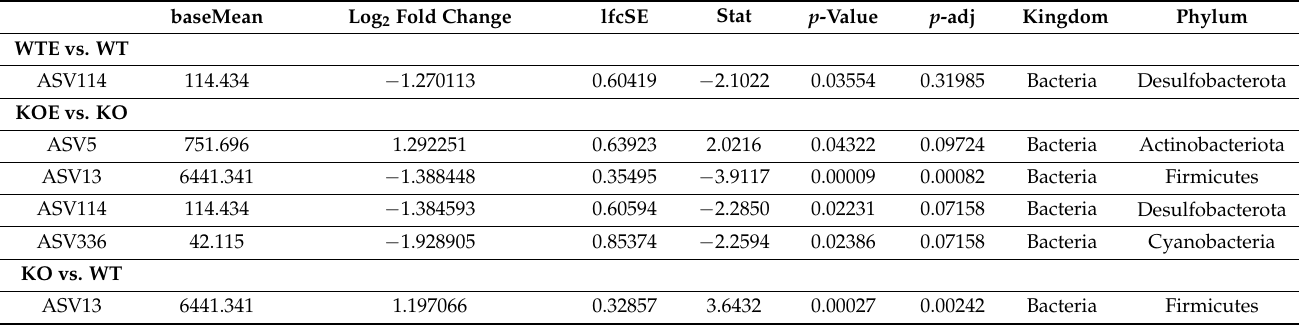
Table 1. Differential expression in the bacteria phylum in WTE vs. WT, KOE vs. KO, and KO vs. WT. Reads of each ASV were merged to their respective phylum level, and a differential expression was conducted using the DESeq2 package. Only the phyla with a raw p -value <0.05 are